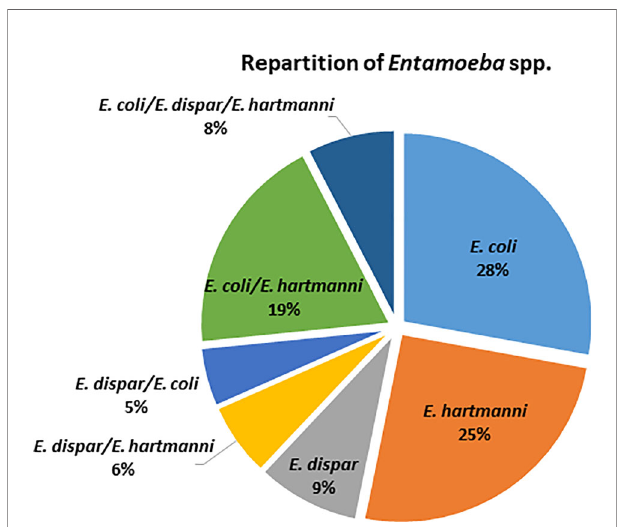
FIGURE 3 | Association patterns between Entamoeba species and Blastocystis subtypes in Cameroonian individuals. Only species/subtypes with at least one signi fi cant correlation are shown. E, Entamoeba ; ST,